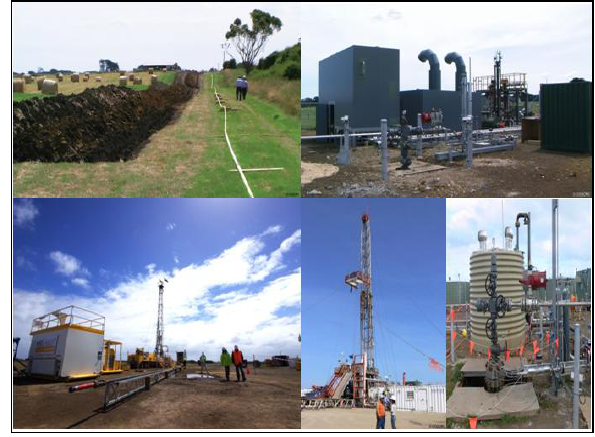
Figure 2. Execution phase at Otway CO2CRC